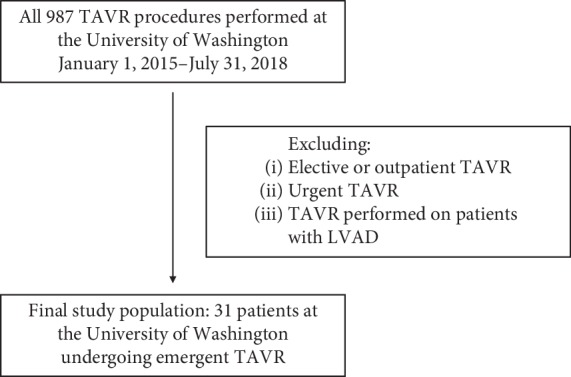
Flow chart showing selection of study population. LVAD: left ventricular assist device; TAVR: transcatheter aortic valve replacement.